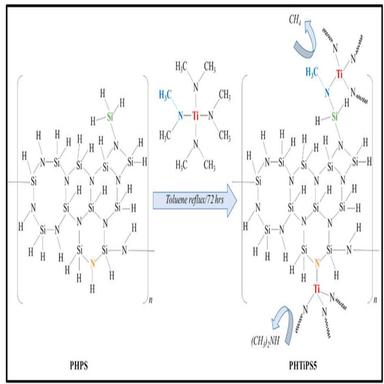
Example ot the synthesis procedure for the preparation of a SiTiN single-source precursor (SSP) according to references. PHP = Perhydropolysilazane; PHTiPS5 = Polytitano-silazane with Si/Ti ratio of 5. The SSP PHTiPS is finally converted to an amorphous/nano-crystalline SiTiN ceramic in ammonia atmosphere at 1000 ◦C with a ceramic yield of about 75 wt%.